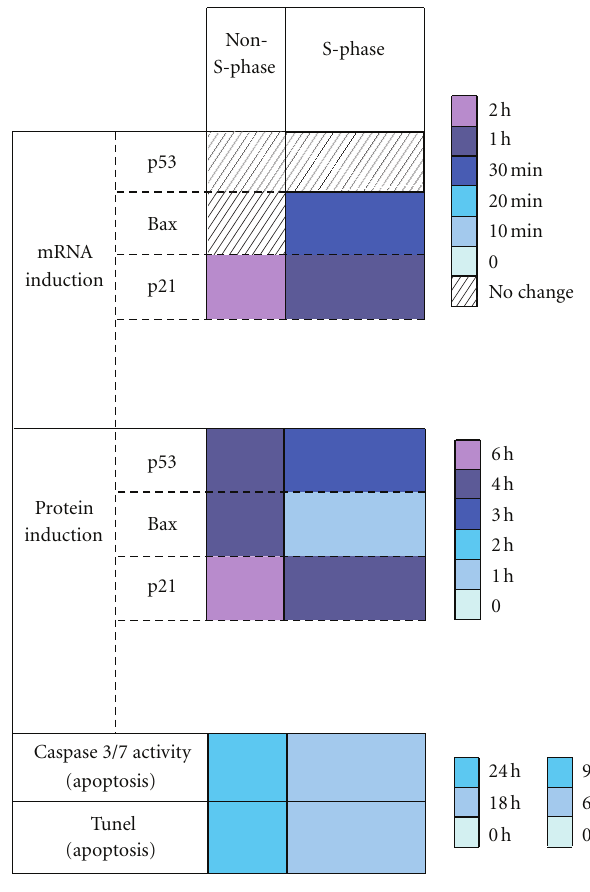
undergoing apoptosis. The results of these assays demon- strate that by 18 h after drug exposure, the number of cells compared to the same time point in non-S-phase